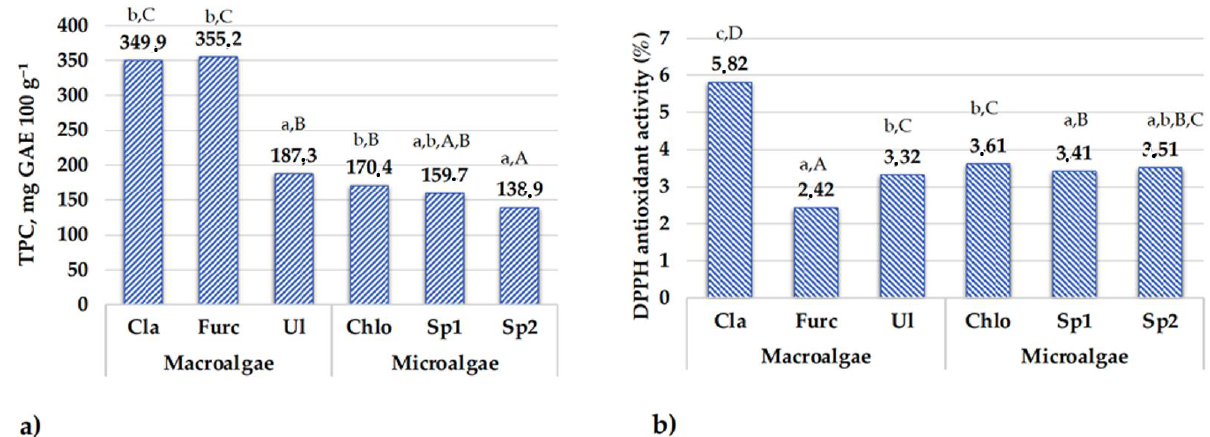
Figure 4. ( a ) Total phenolic compound content (mg GAE 100 g − ) and ( b ) DPPH antioxidant activity (%) of the algae extracts (Cla, Cladophora rupestris ; Ul, Ulva intestinalis ; Furc, Furcellaria lumbricalis ; Chlo, Chlorella vulgaris ; Sp1, Spirulina ( Arthrospira platensis ) multiplied in the laboratory; Sp2, Spirulina (Ltd. „Spila“); TPC, total phenolic compounds content; GAE, gallic acid equivalents; DPPH, 1,1-diphenyl-2-picrylhydrazyl; a–c for the same analytical parameters, in macro- and microalgae groups, means with different letters are significantly different ( p ≤ 0.05). A–D for the same analytical parameters, in all algal samples, means with different letters are significantly different ( p ≤ 0.05)). Table 1. Colour coordinates (L*, a*, b*) of the lyophilized ground algae samples of different specimens and their extracts. Colour Coordinates, NBS Algal Extract Sample Algal Extract Samples Lyophilised Algal Samples